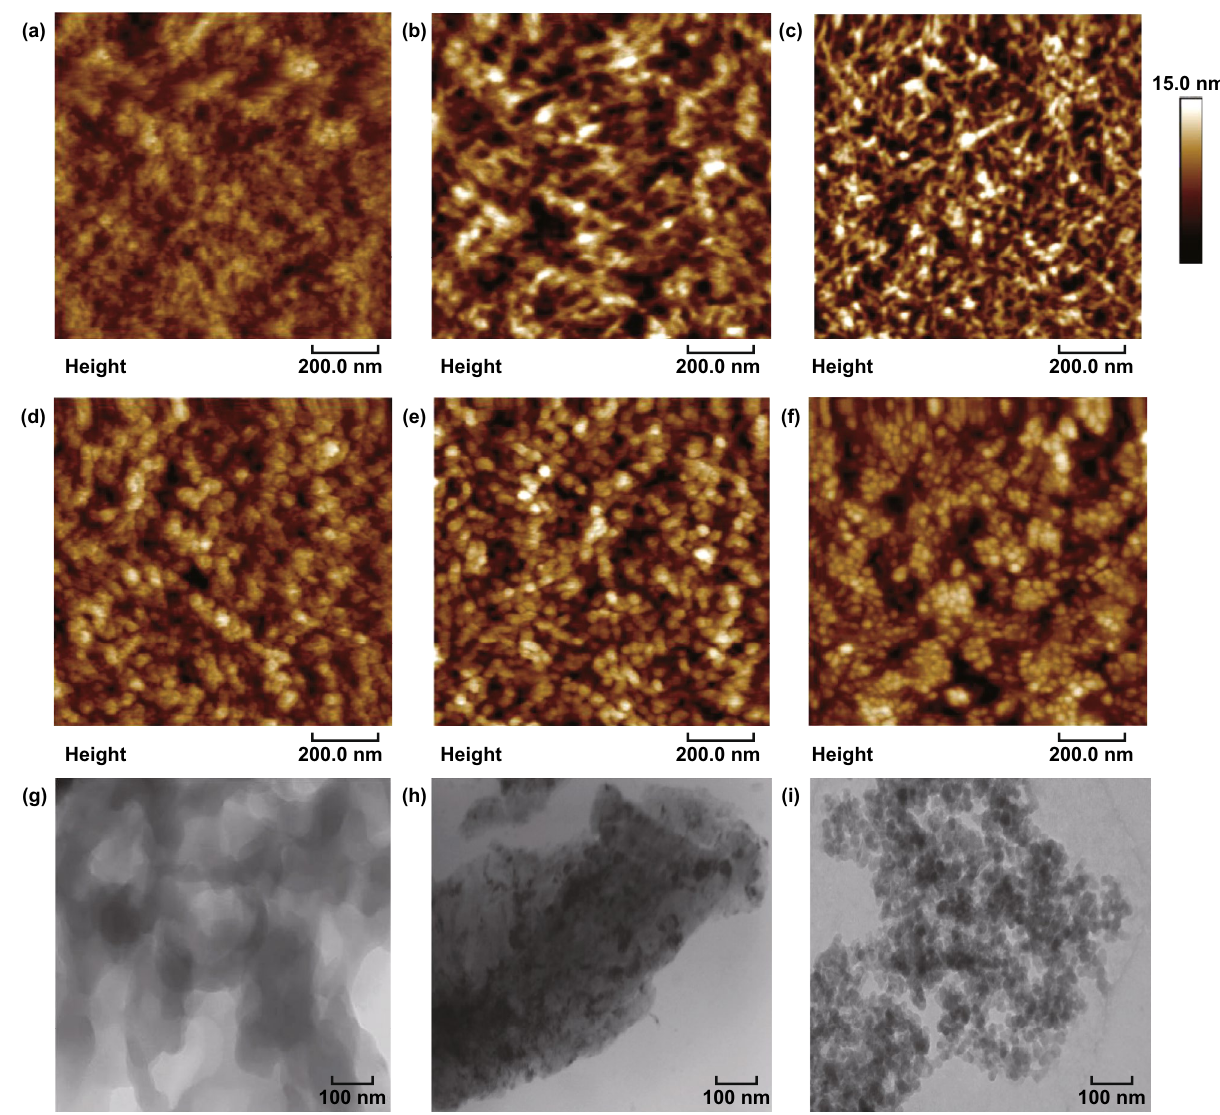
Fig. 2 Morphological characteristics of PEDOT:PSS films. a , g As-cast films. The films with the 0.8 M CF 3 SO 3 H treatments at the tempera- tures: b RT; c , h 50 °C; d 100 °C; e , i 140 °C; and f 180 °C. Scale bar: 100 nm for g , h, and